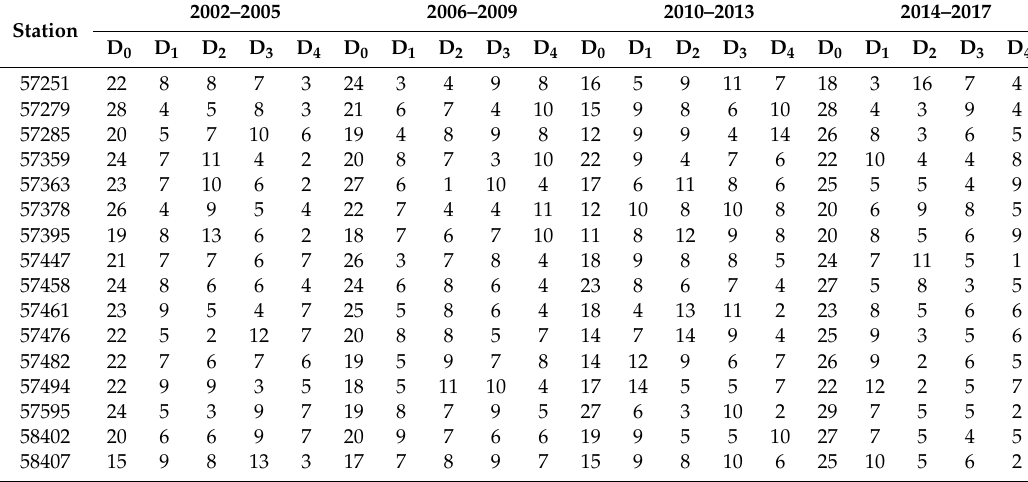
Table 2. Number of Drought Category Events in Four-year intervals from 2002 to 2017.